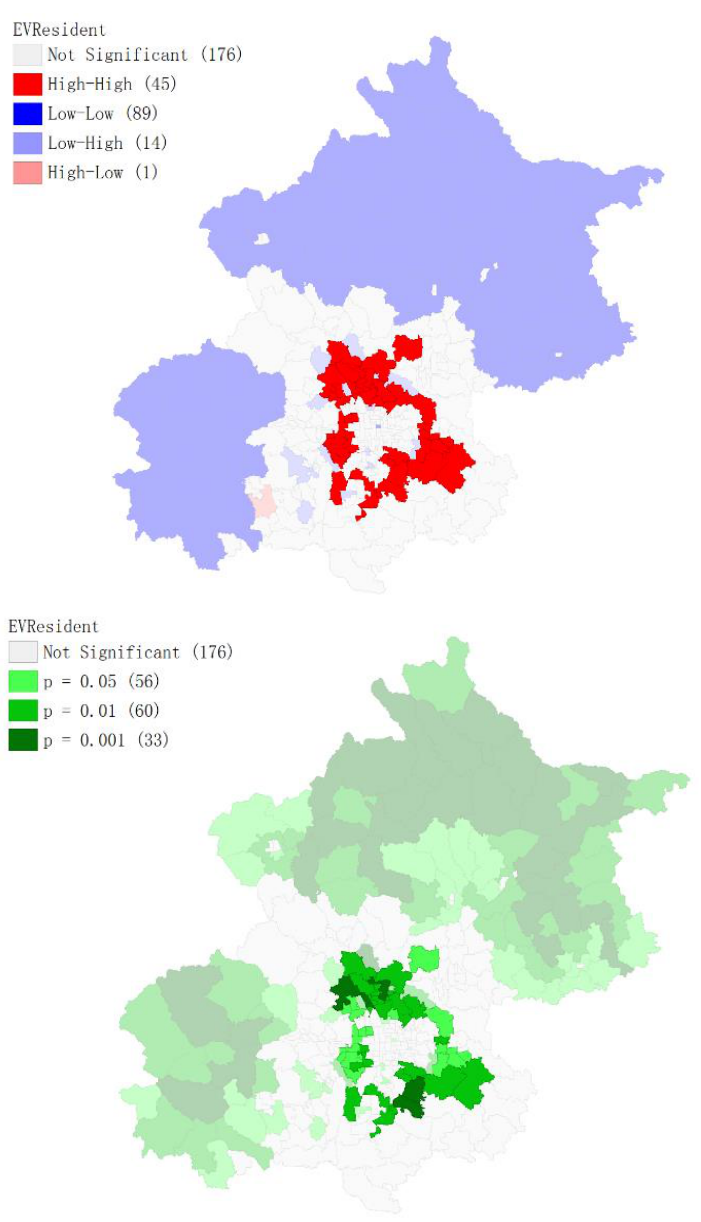
Figure 5. LISA cluster map and LISA significance map (weights: Queen Weights): the high–high cluster is highlighted in red, and the corresponding significance results highlight in green. It shows an obvious clustering trend beyond the urban core areas but along with the fifth and sixth ring roads. Clearly, the rural areas outside the sixth ring road show low-low cluster features .